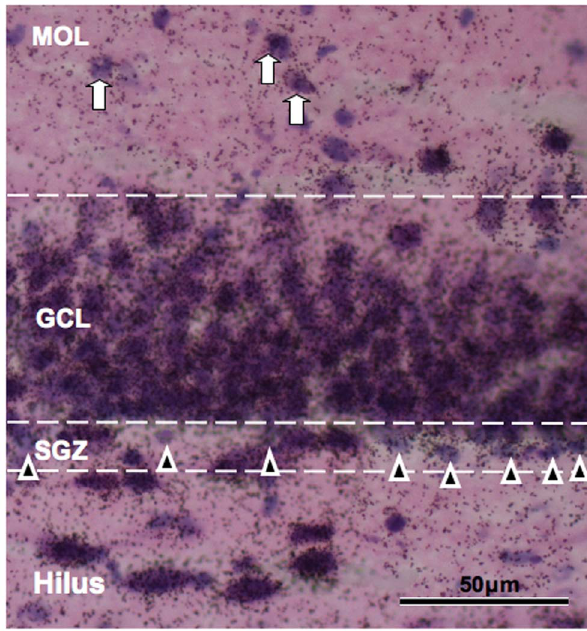
Figure 7. Expression of Pro + 9 mRNA at P21. Pro + 9 mRNA expression in the dentate gyrus at P21. Neurons (arrowheads) in the subgranular zone (SGZ) show lower staining levels of Pro + 9 mRNA expression compared with neurons in the granule cell layer (GCL). Neurons in the hilus show intense staining of Pro + 9 mRNA expression. A number of neurons (arrows) in the molecular layer (MOL) also show moderate mRNA expression levels.